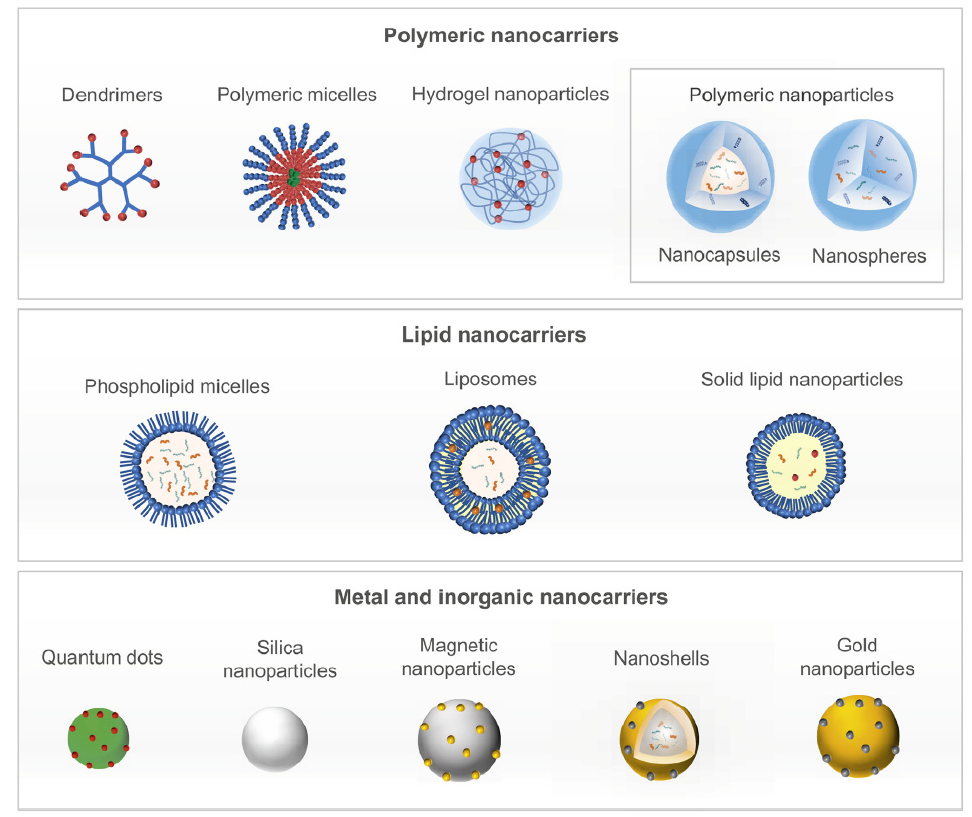
Figure 1. Major classes of nanoparticles (NPs) under clinical trial for cancer therapy. Reprinted with permission from Elsevier [17].